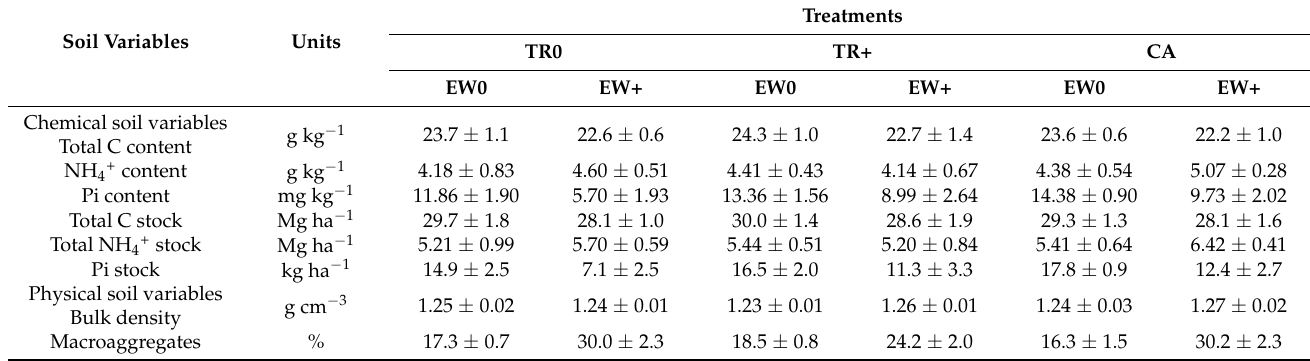
Table 2. Mean ± SE for soil variables measured at the end of the 3rd cropping season (2016). Treatments are abbreviated as follows: TR0: traditional tillage without rice residues restitution, TR+: traditional tillage with rice residues restitution, CA: conservation agriculture system; EW0: without earthworm inoculation, EW+: with earthworm inoculation.